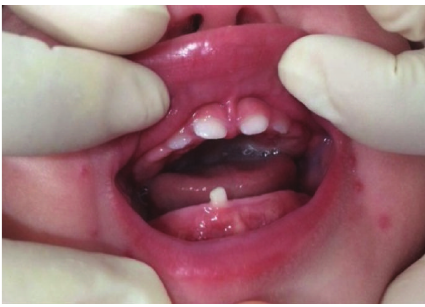
Figure 4: One year of follow-up showing no signs of recurrence of the lesion.